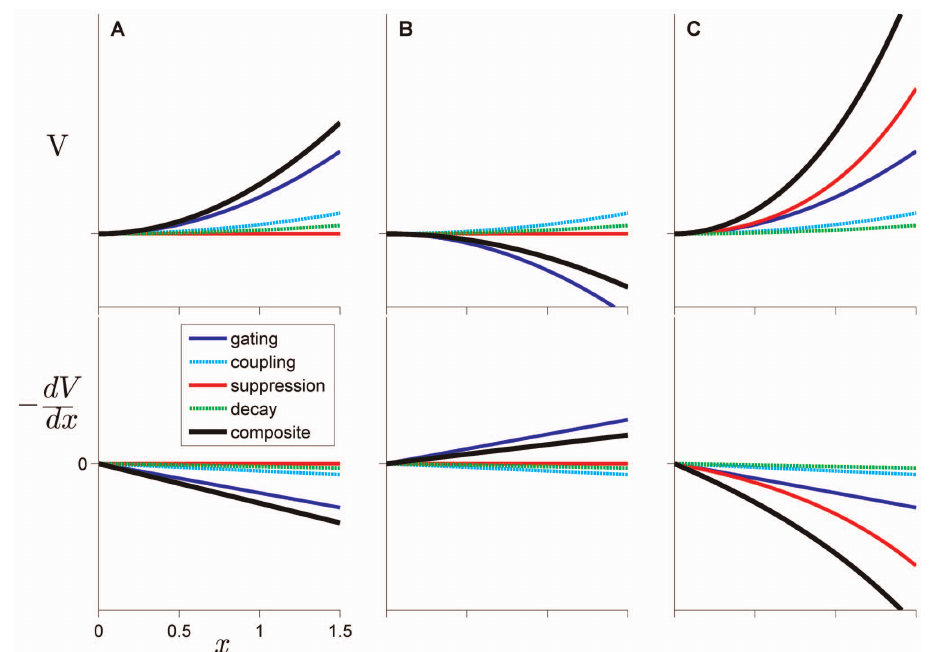
Figure 5. Activation potential functions and corresponding vector fields from three stages of articulatory production: (A) prior to response intention, (B) after response intention before selection, (C) after selection. Composite (black lines) and component functions (colored lines) are shown.